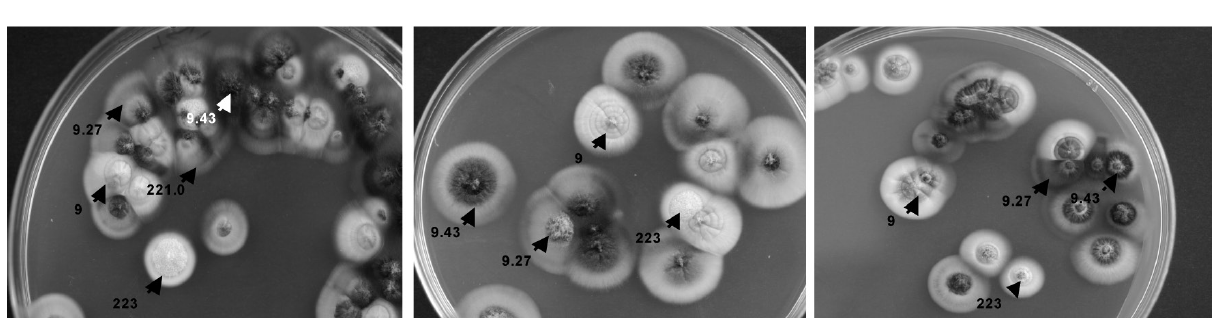
Figure 6. Recovery of P. chlamydospora in PDA dishes at several intervals after artificial inoculation on vineyard soils. Different types of colonies correspond with some of the five morphotypes inoculated (Pch 9, 223, 221.0, 9.27 and 9.43). a, 1 month after inoculation; b, 3 months after inoculation, and c, 36 months after